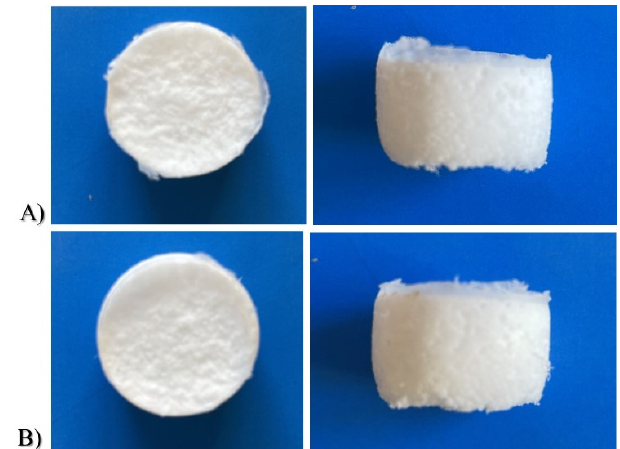
Figure 1. Representative images of the general aspect of the PCL-based scaffolds: pure PCL ( A ) and 30% EO-added PCL ( B ) samples with NaCl.